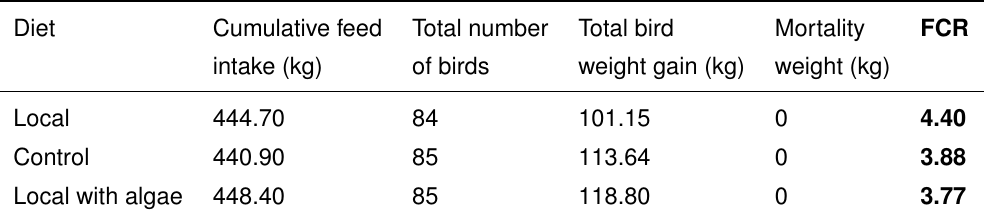
Table 4. The feed conversion calculation (FCR) for the winter feed trial for the experimental period showing the cumu- lative feed intake, weight gain and